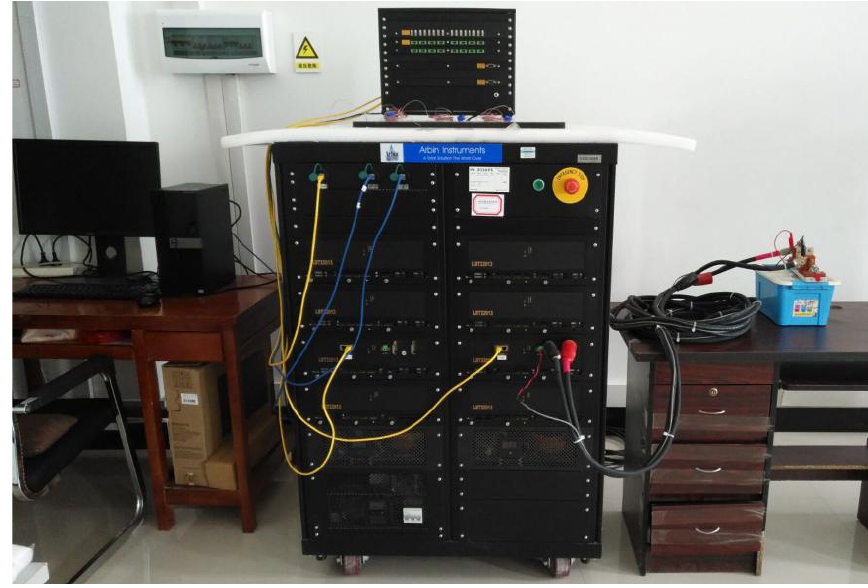
Figure 2. Arbin test rig and NCM532 lithium-ion batteries.